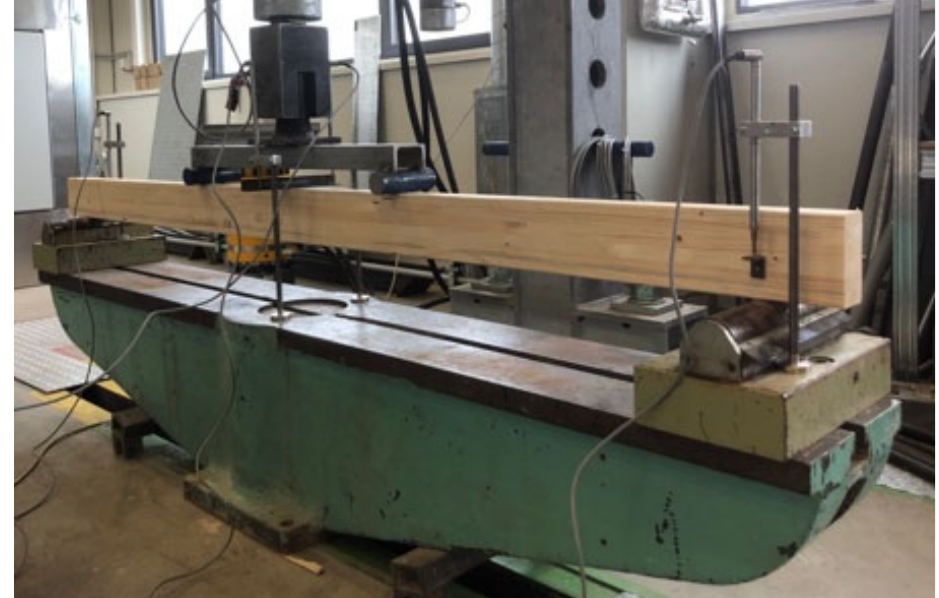
Figure 5. Test of the GLT testing body in the four-point bending test (authors’ archive). Since the testing bodies were not conditioned in a standard environment with a temperature of (20 ± 2) ◦ C and a relative humidity of (65 ± 5)%, the moisture content of the samples was not the required 12% but ranged around 8%. The obtained values of the bending strength and modulus of elasticity of the tested samples were adjusted for values corresponding with a 12% moisture content f m ,12 and E m ,12 according to the standards [19,39,40].